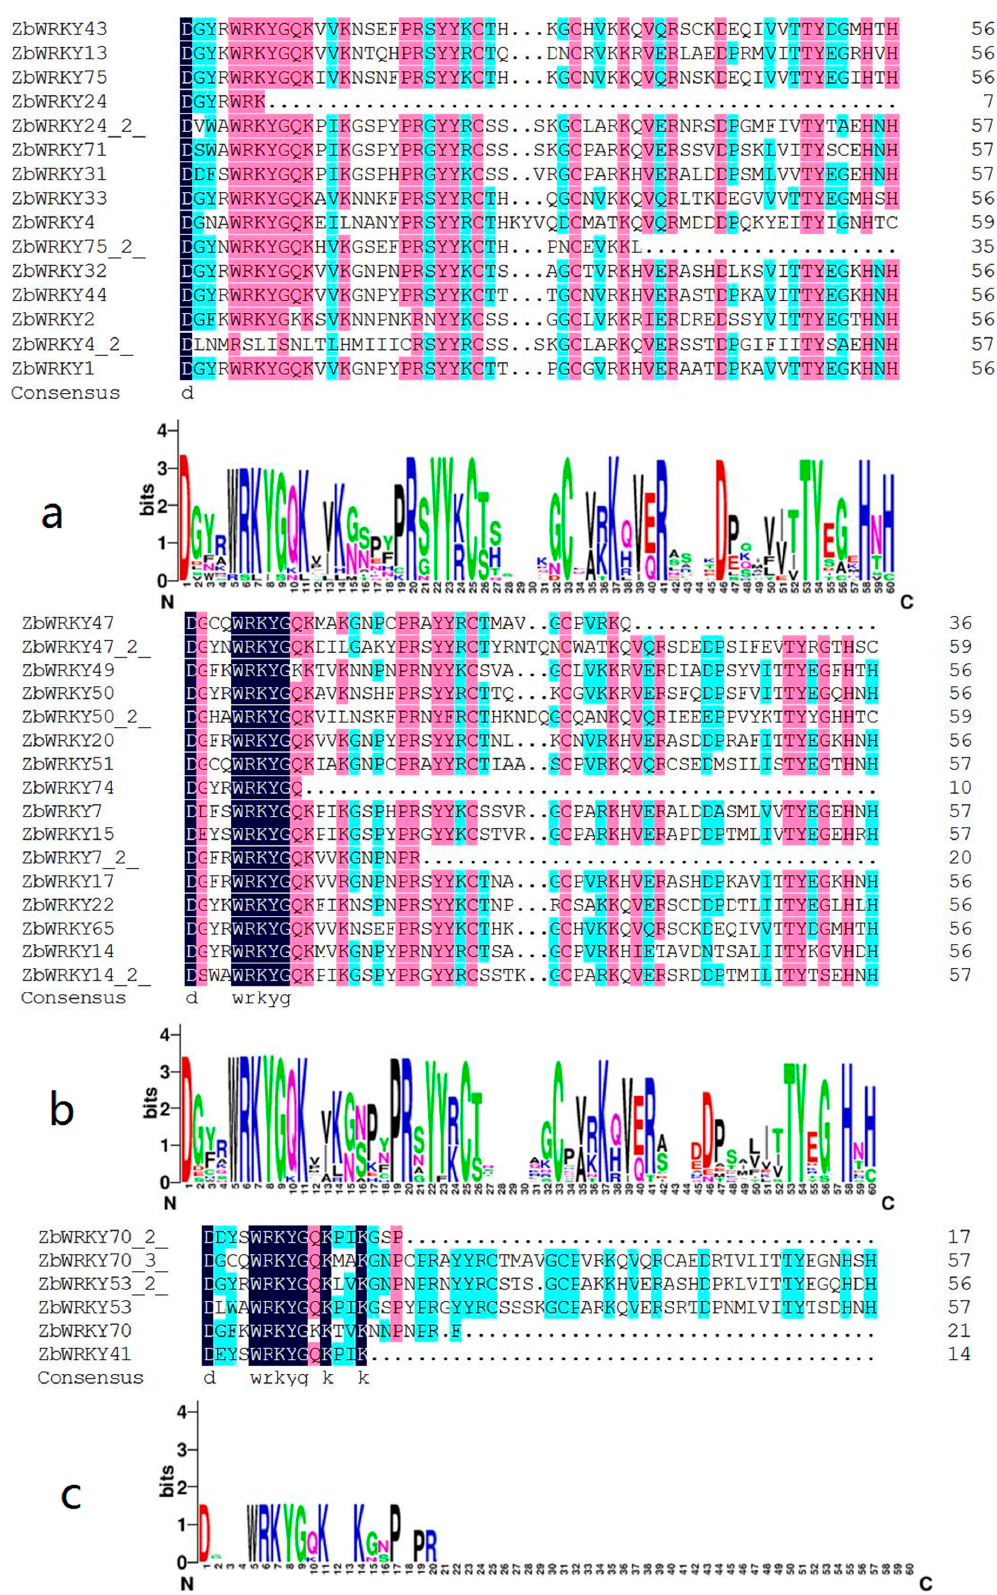
Figure 2. Multiple alignment of WRKY proteins in Zanthoxylum bungeanum : ( a ) Group I, ( b ) Group II, and ( c ) Group III.